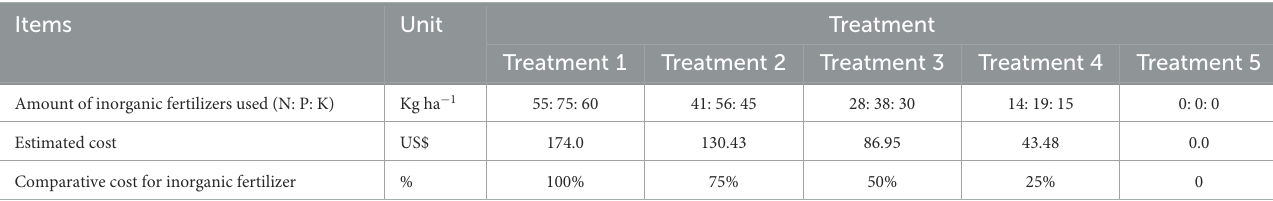
TABLE 6 Economic efficiency of Malabar spinach ( Basella alba L.) and Amaranthus cruentus ( Amaranthus L.) vegetables production by reducing inorganic fertilizers. Items Unit Treatment Treatment